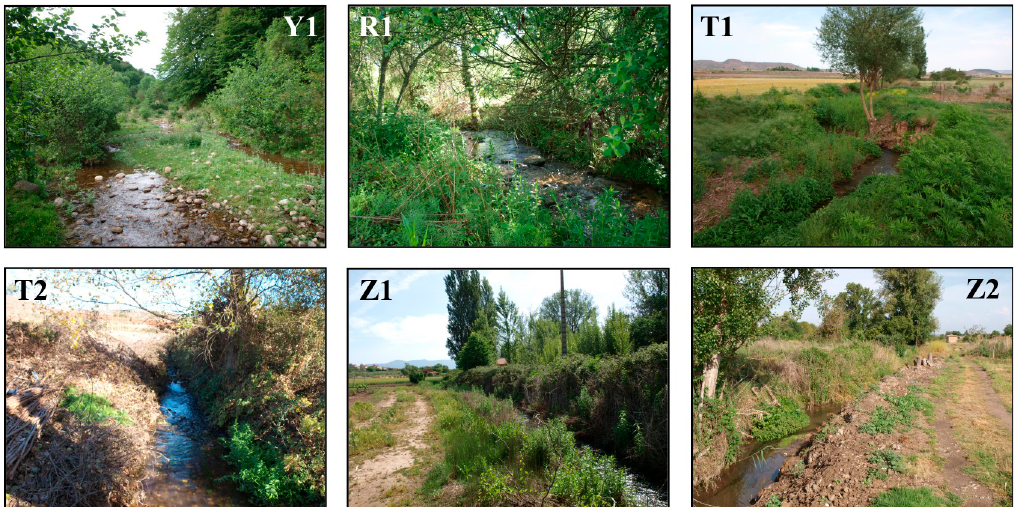
Fig 5. Photographs of the studied sites with the highest (white acronyms) and the lowest (black acronyms) QBR and IHF total values. Y1 (QBR = 80; IHF = 71), R1 (75; 71), T1 (10; 29), T2 (35; 31) Z1 (10; 32), Z2 (10; 36).